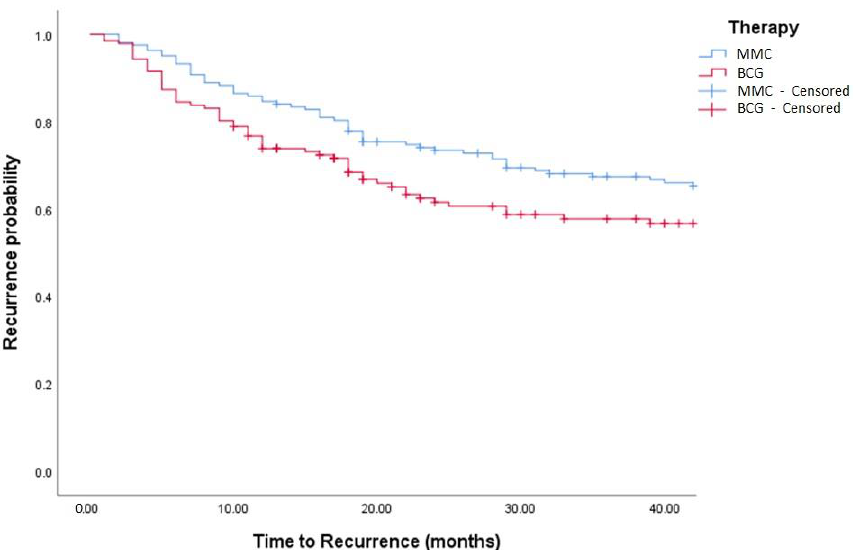
Figure 3. Kaplan – Meier in BCG vs. MMC in TCC patients (log-rank, p = 0.271). BCG = Bacillus Calmette Guerin. MCC = Mitomycin C.